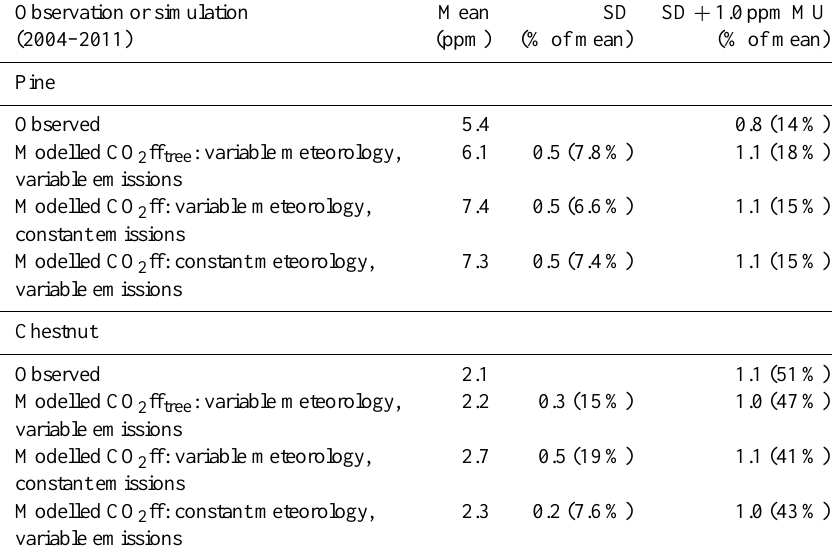
Table 1. Observed and modelled CO 2 ff means and standard deviations at the locations of the pine and chestnut tree between 2004 and 2011. All means and standard deviations (SD) include six years (2008 and 2010 are omitted because there are no observations available for these years). Measurement uncertainty (MU) of 1.0ppm is explicitly added to the modelled results in the far right column. Observations implicitly include this